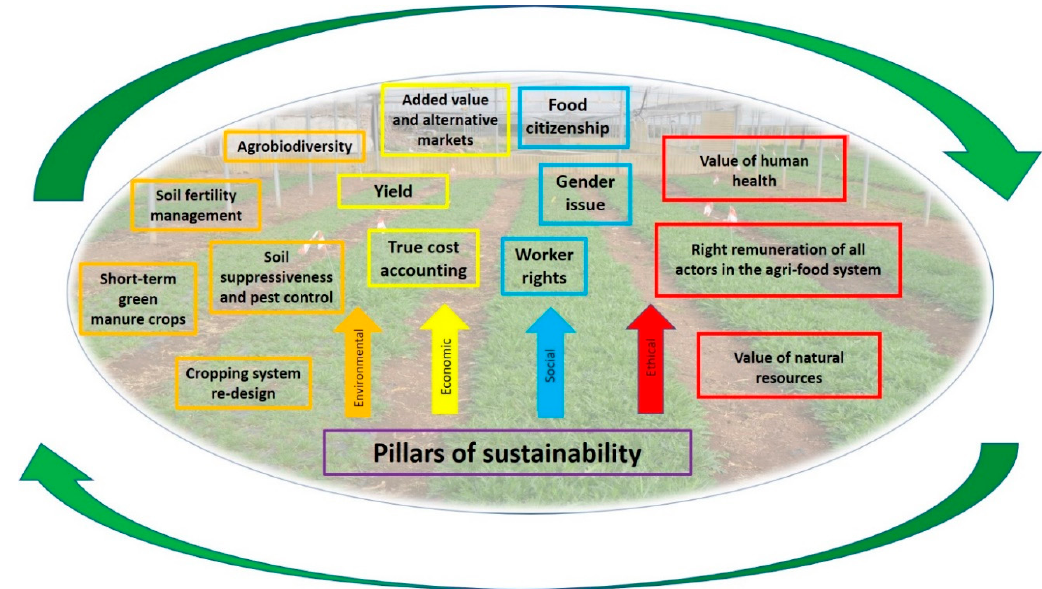
Figure 1. Multidimensional components of sustainability in an agroecological approach to organic greenhouse production.